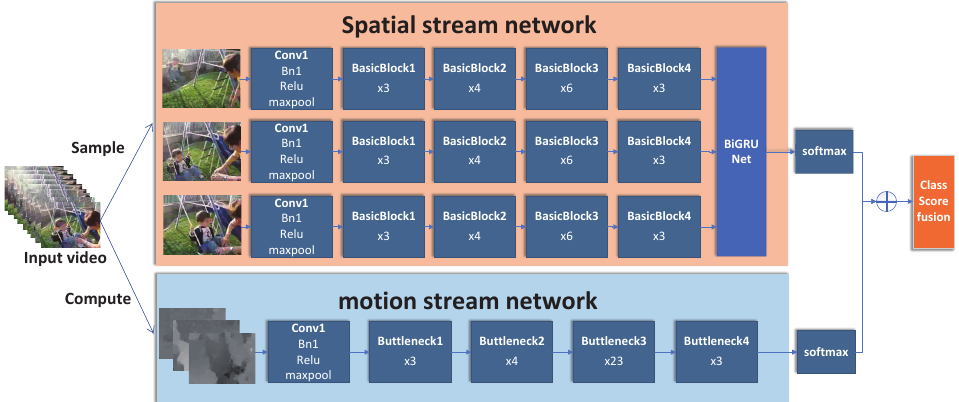
Figure 3. Improved two-stream convolution network